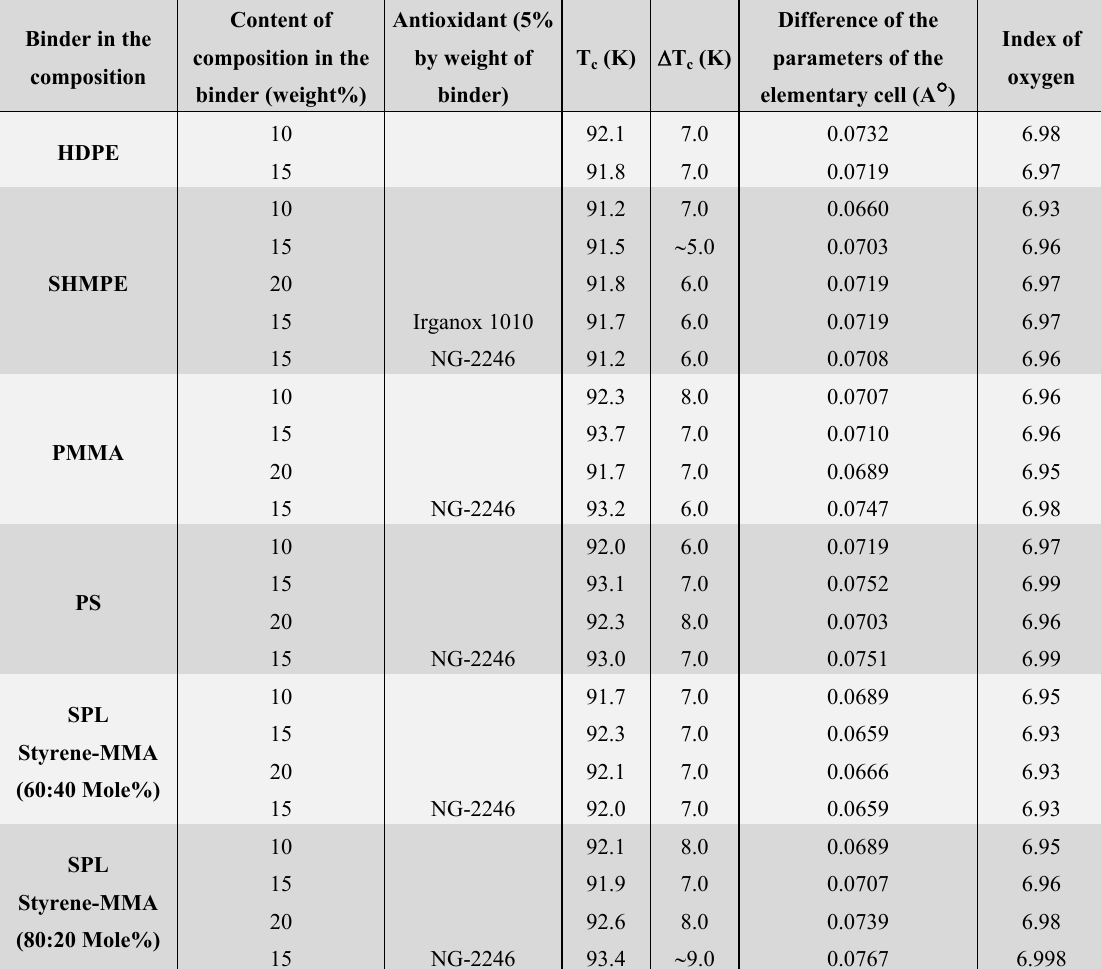
Table 2. SC characteristics of the nanocomposites based on Y ( t =130 ° C, τ press.